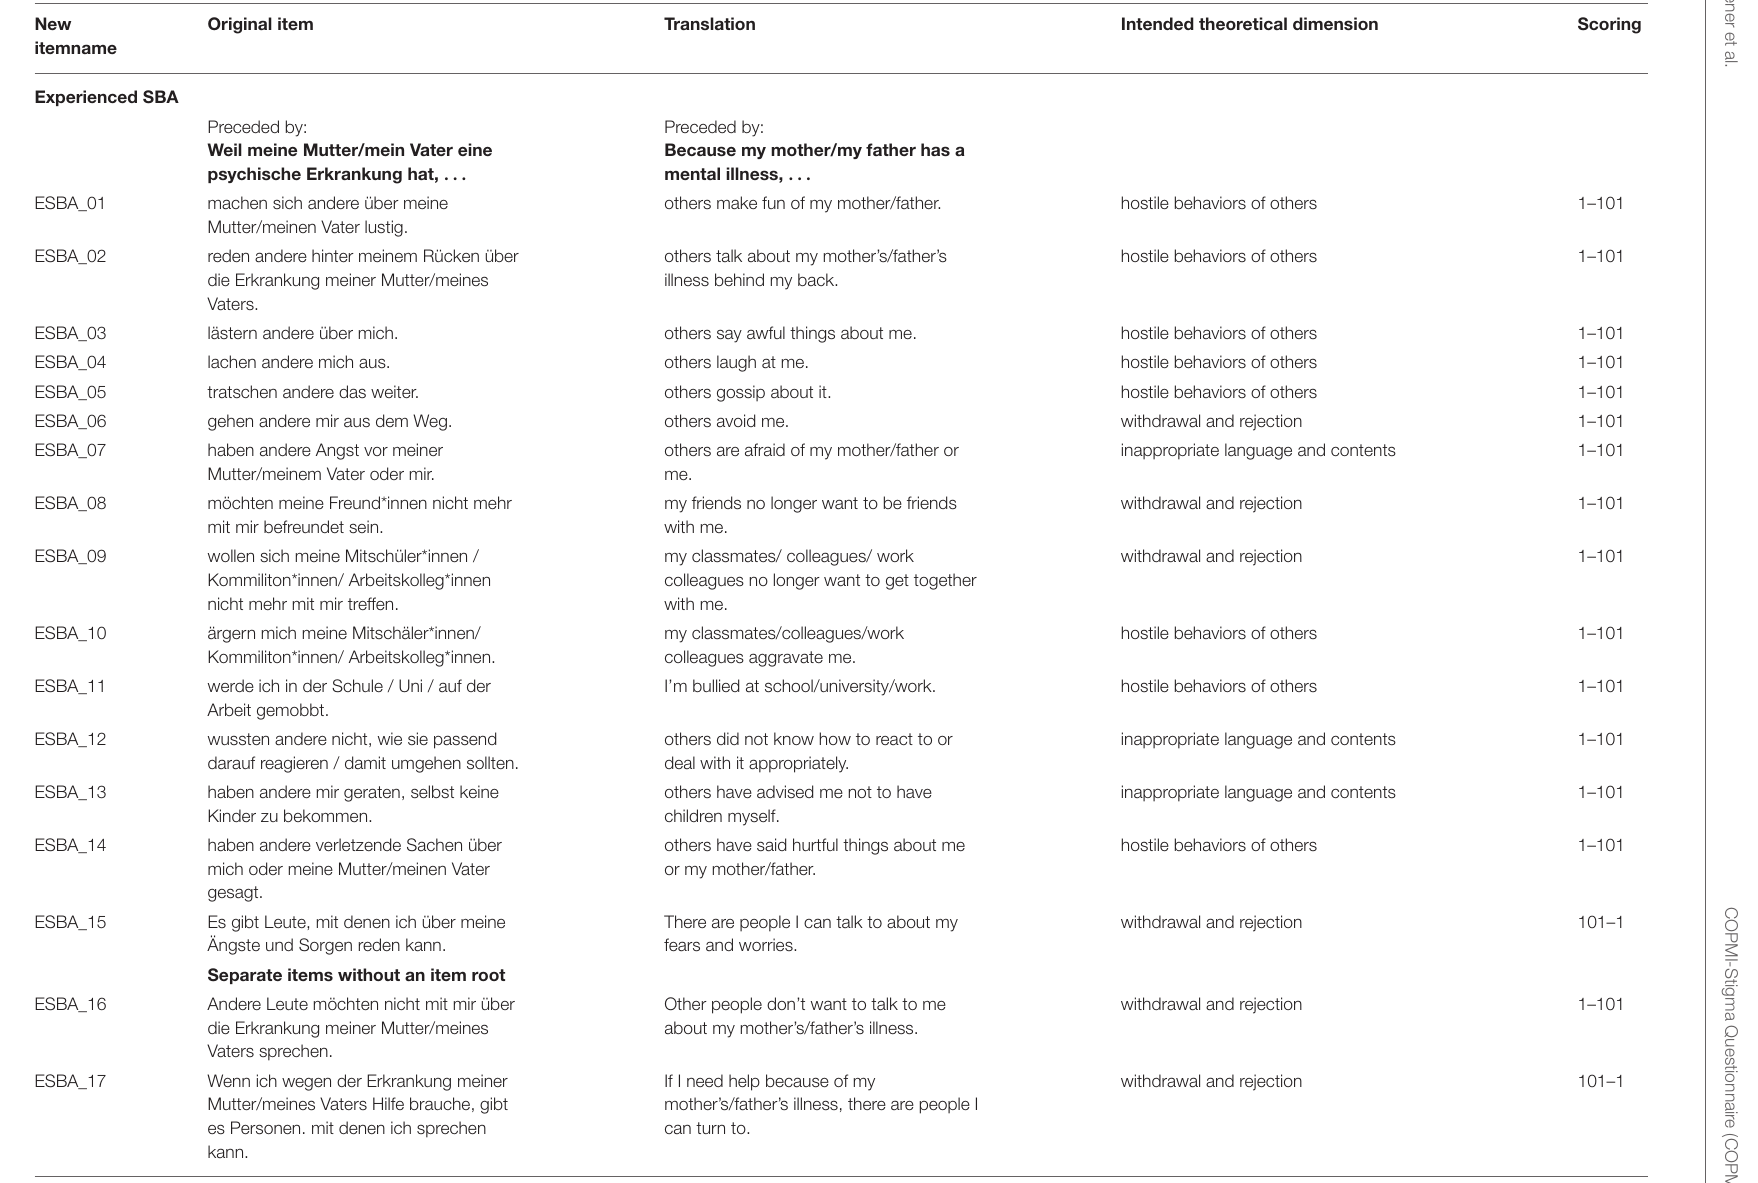
TABLE 2 | Overview of the revised COPMI-SQ after item